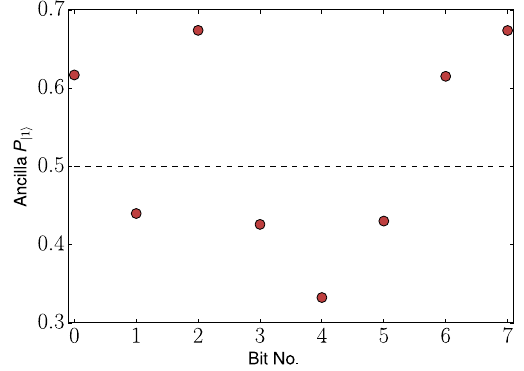
FIG. 7. Example data for a single PEA experiment, run at R ¼ 1 . 55 Å. The results are shown without phase kickback from the measurements of the previous bit. The line at P discriminates a measurement of 1 from